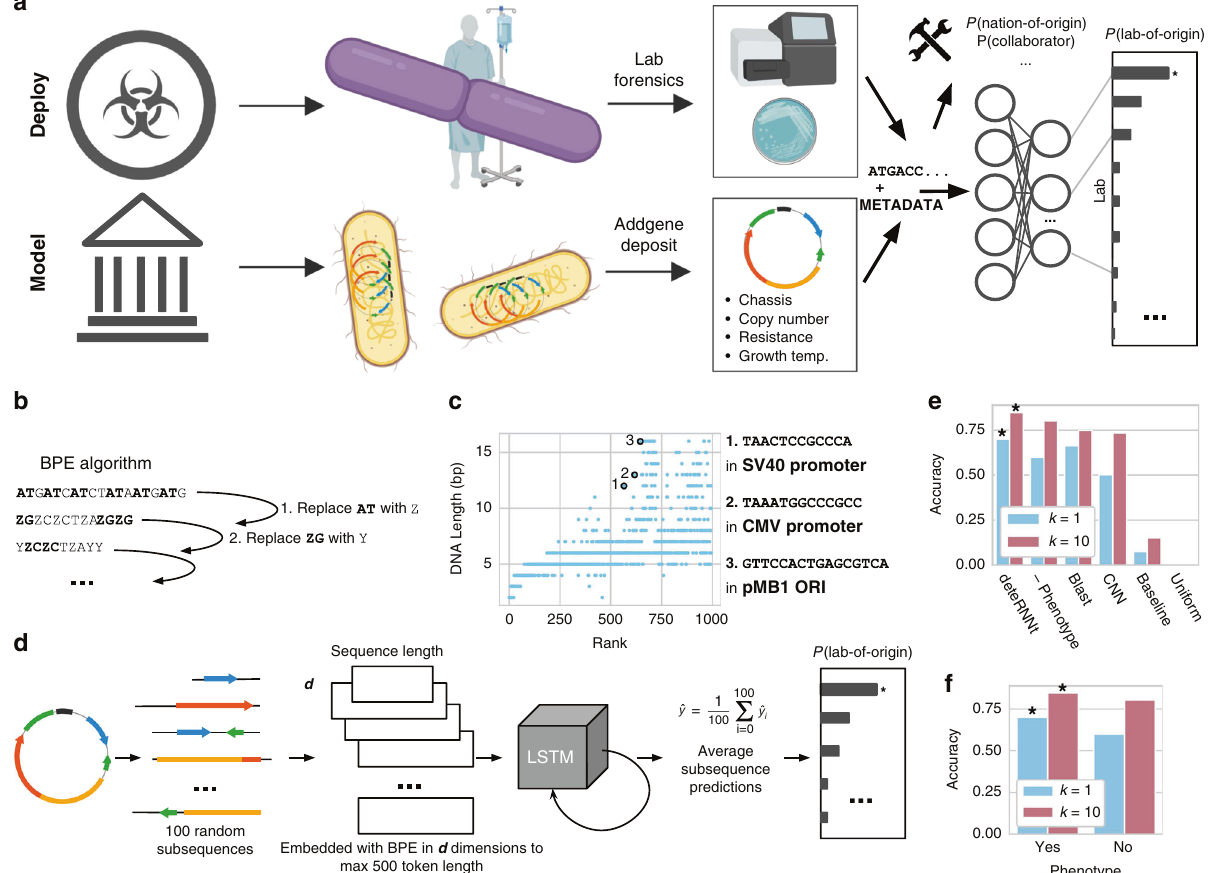
Fig. 1 Deep learning on DNA motifs and minimal phenotype information enables state-of-the-art genetic engineering attribution. a The Addgene plasmid repository (bottom) provides a model through which to study the deployment scenario (top) for genetic engineering attribution. In the model scenario, research laboratories engineer organisms and share their genetic designs with the research community by depositing the DNA sequence and phenotypic metadata information to Addgene. In the corresponding deployment scenario, a genetically engineered organism of unknown origin is obtained, for example, from an environmental sample, lab accident, misuse incident, or case of disputed authorship. By characterizing this sample in the laboratory with sequencing and phenotype experiments, the investigator identi fi es the engineered sequence and phenotype information. In either case, the sequence